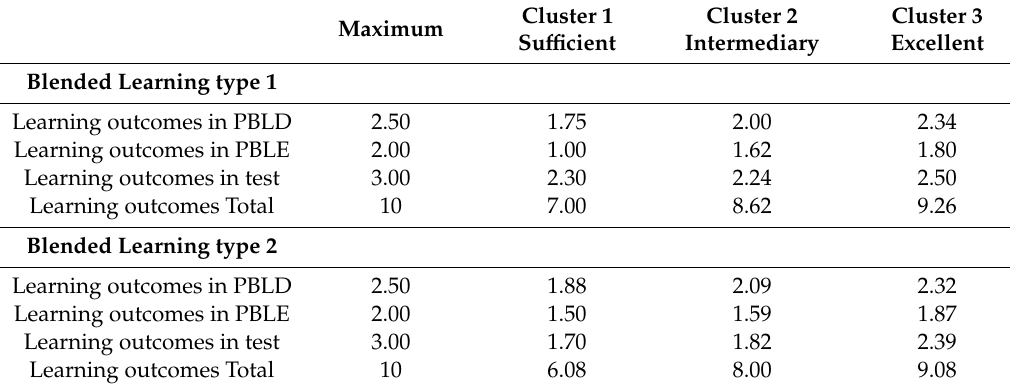
Table 5. Centers of final clusters for the learning results variable in Blended Learning type 1 and type 2,